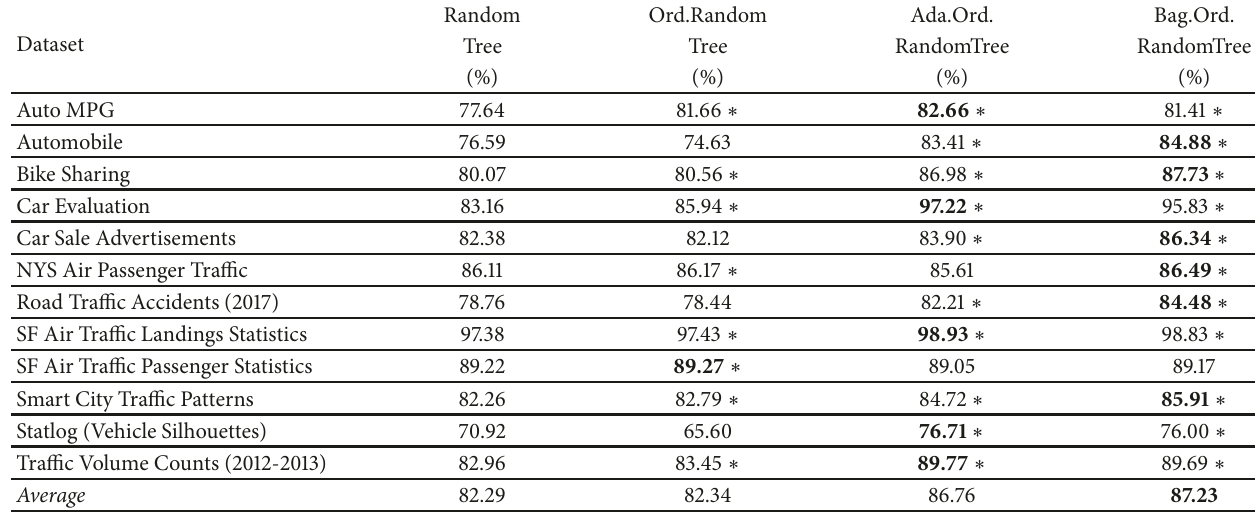
Table 4: The comparison of RandomTree based ordinal and ensemble learning methods in terms of classification accuracy. Random Dataset